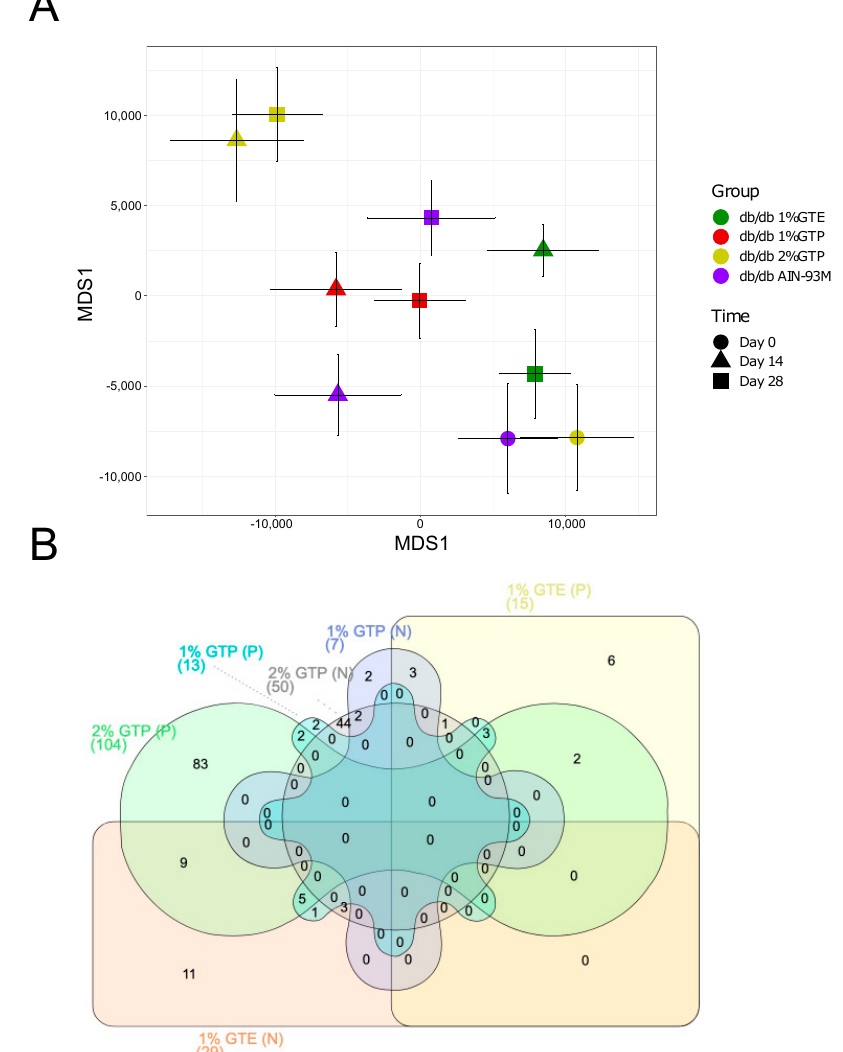
Figure 6. Effects of GTE and GTP treatments on the gut microbiota function. ( A ) Multidimensional scaling plots for gut microbial pathway profiles based on Euclidean distance. Each data point represents the mean ordination value and the error bar represents the SEM of each group. Stress = 0.11. ( B ) Venn diagram of the number of pathways which were associated with GTE and GTP treatment. Log-transformed abundance of the pathways from PICRUST2 at Day 28 were used. Multivariate association with linear models 2 (MaAsLin2) was applied to explore the association between green tea compound supplements and pathways with adjustment for food and water consumption. Compared with the db / db AIN-93M group, adjusted p < 0.25 is considered significant in each treatment group. For each treatment, (P): compared with the db / db AIN-93M group, the pathways were positively associated with the treatment; (N) compared with the db / db AIN-93M group, the pathways were negatively associated with the